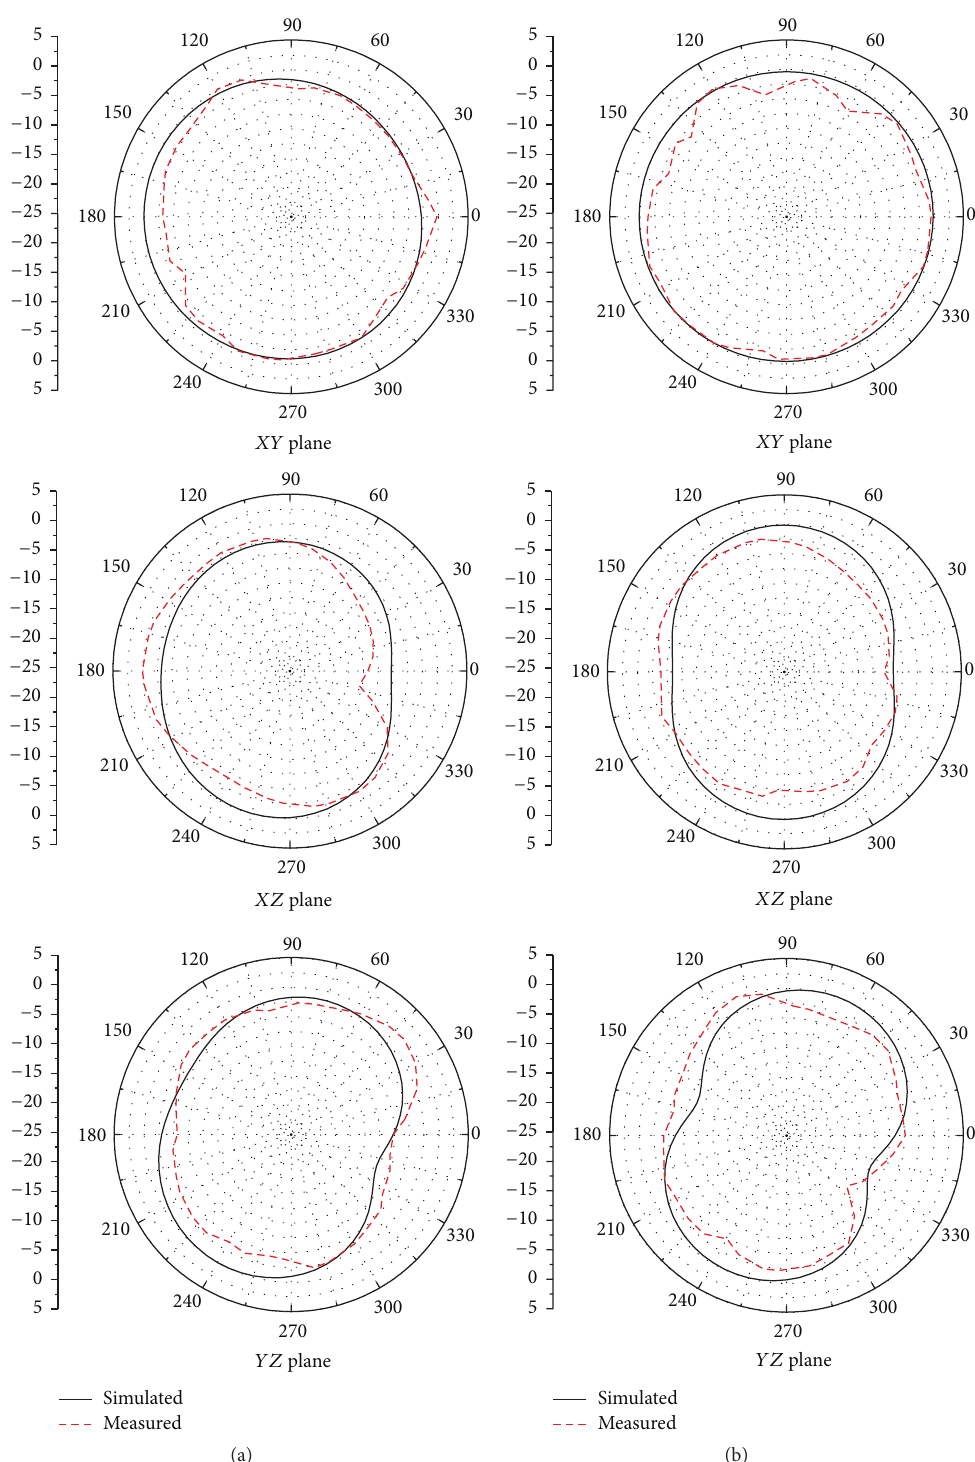
Figure 11: Simulated and measured 2D patterns of the proposed antenna. (a) 700 MHz; (b) 750